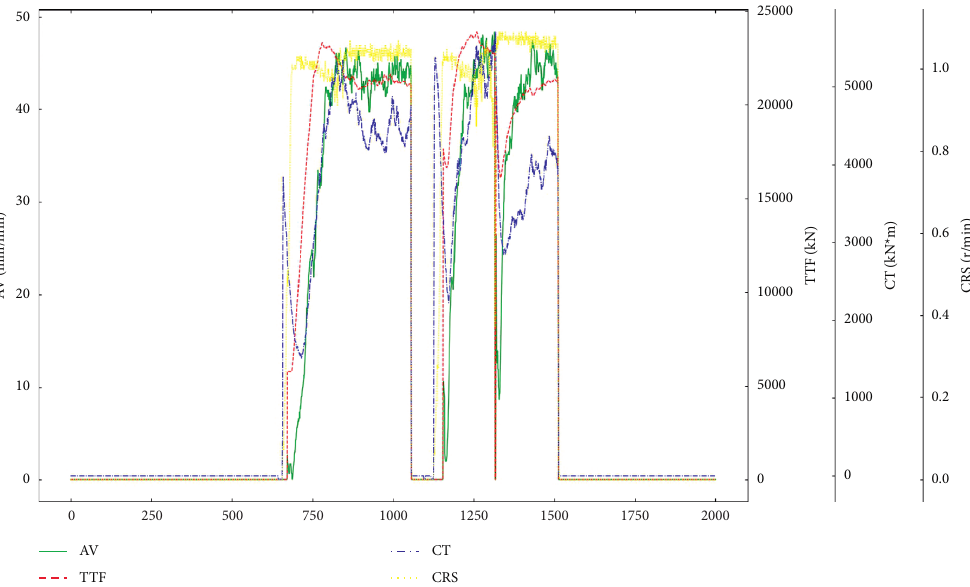
Figure 1: Local curves of some key TBM operation parameters in Ring 550.